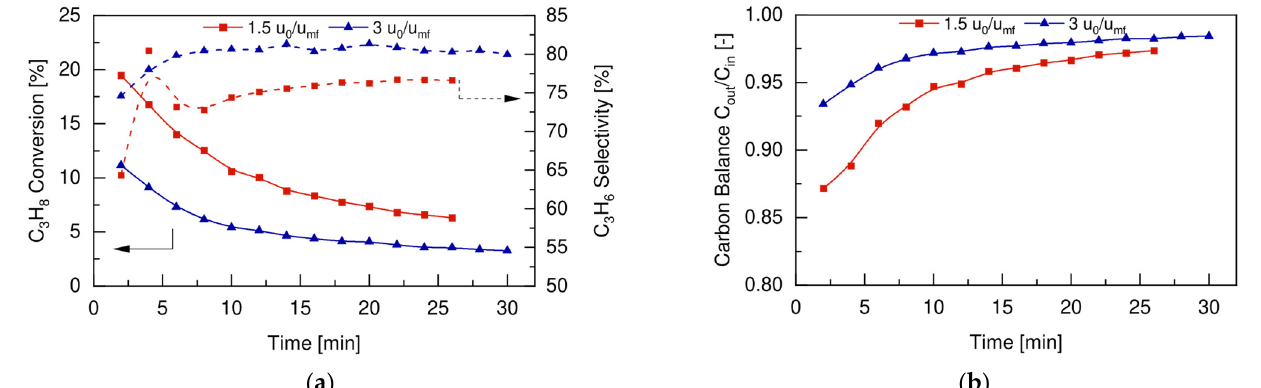
Figure 6. Fluidized bed reactor ( a ) performance and ( b ) carbon balance for different u 0 /u mf ratios, at 500 °C, 1 bar and with a feed composition of 30vol% C 3 H 8 -70vol% N 2 .